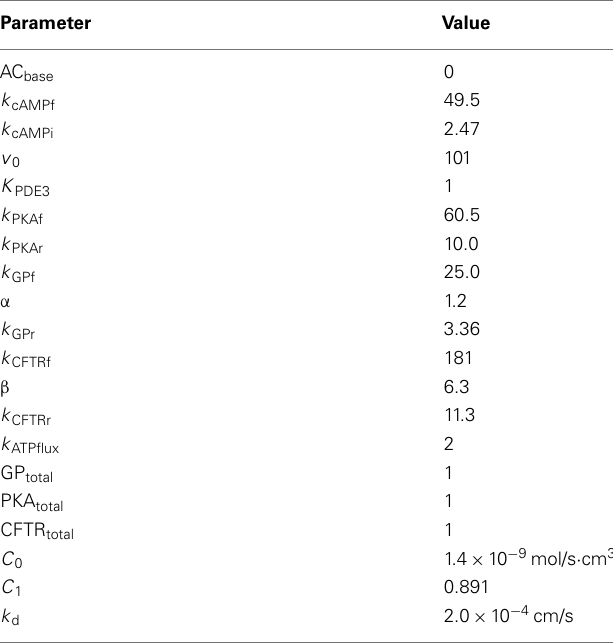
Table 1 | Parameters forATP release pathway andATP